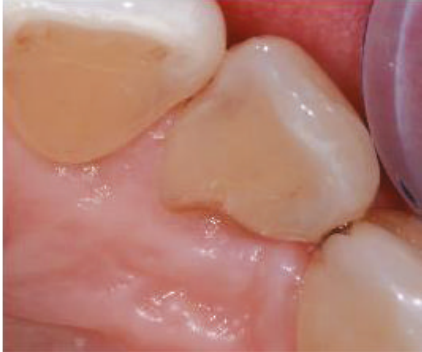
Figure 9: Clinical examination after 12 months.